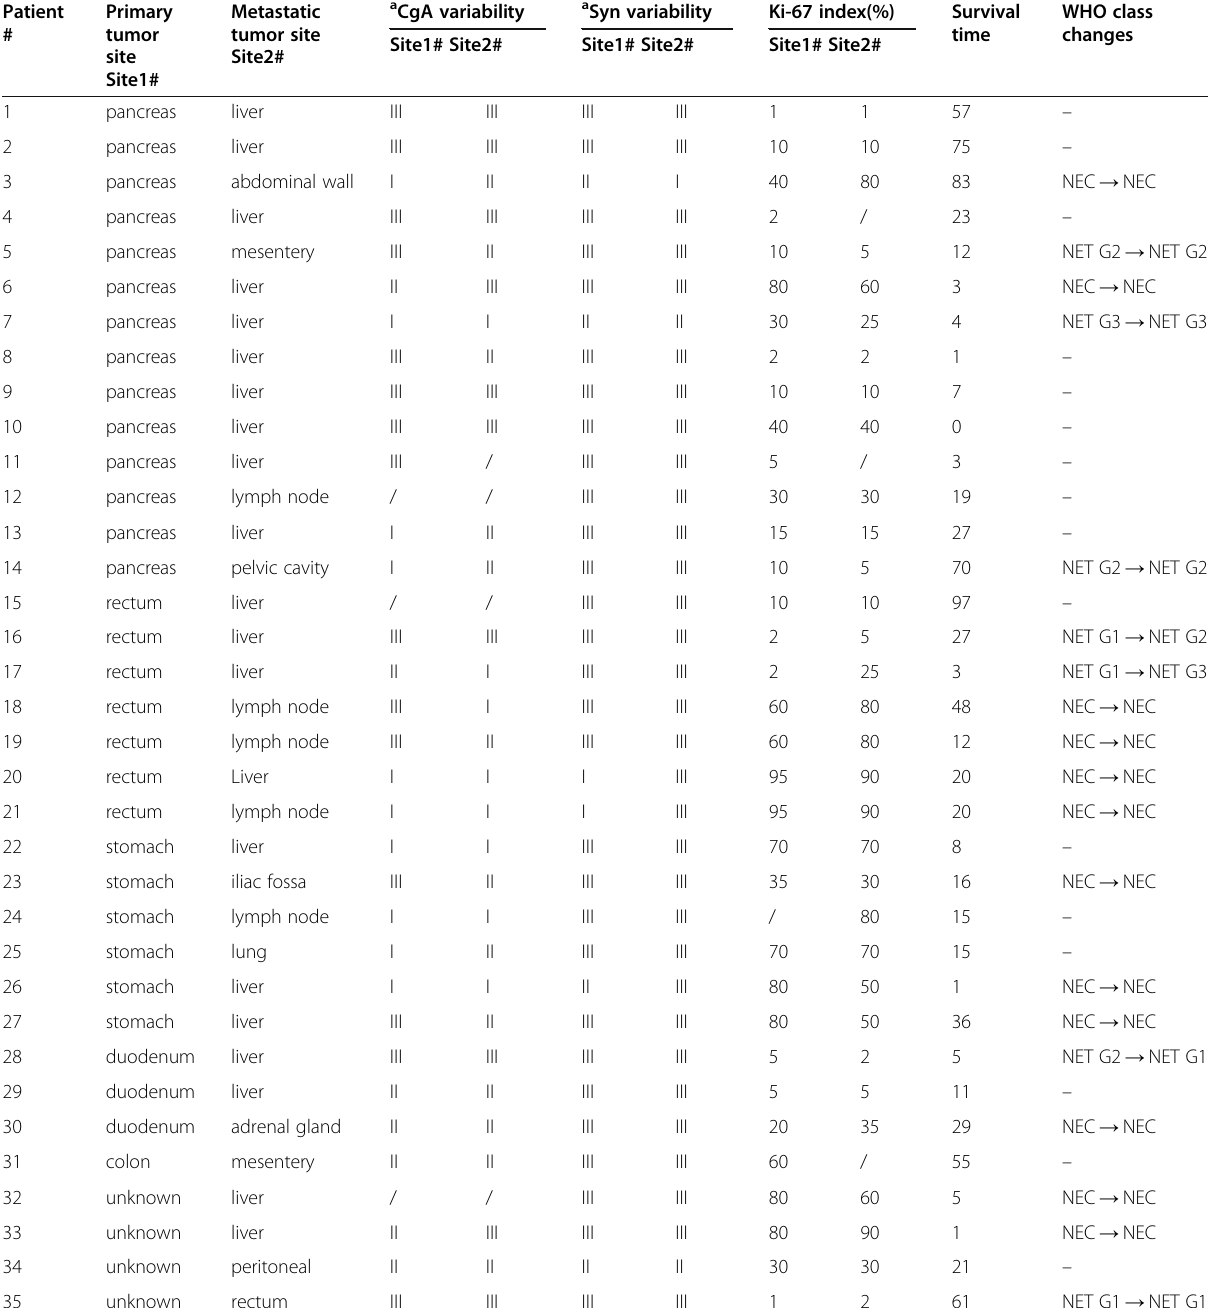
Table 2 CgA, Syn and Ki-67 index variation between primary and metastatic sites Patient